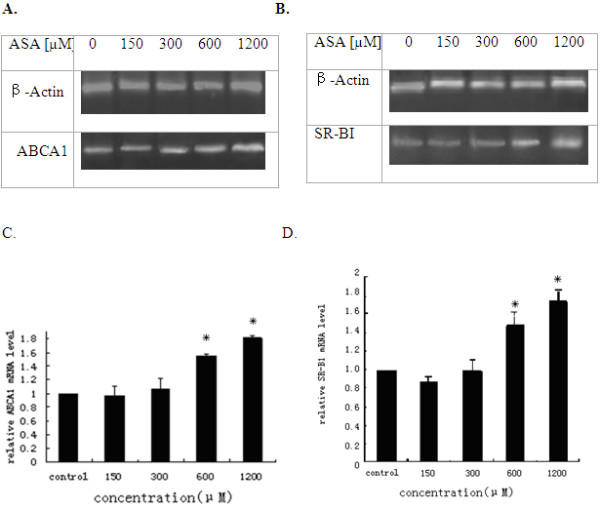
Increases of ABCA1 and SR-BI transcripts by ASA in THP-1 derived macrophages. THP-1 cells were cultured in media containing 10% FBS with different concentrations of ASA for 24 h. Total RNAs were isolated and mRNA levels for ABCA (A), SR-BI (B) with Actin as internal controls were examined by RT-PCR analysis. Amplified cDNA products were applied to 1.5% agarose gels, stained with ethidium bromide and visualized under a UV light (A, B). The signal intensities from gels were qualified by the Quantity One software and transformed to the bar graphs (C, D). Results are expressed as mean ±S.D, of three experiments with duplicated samples. * P < 0.05,compared to control(Figure 6C,D).